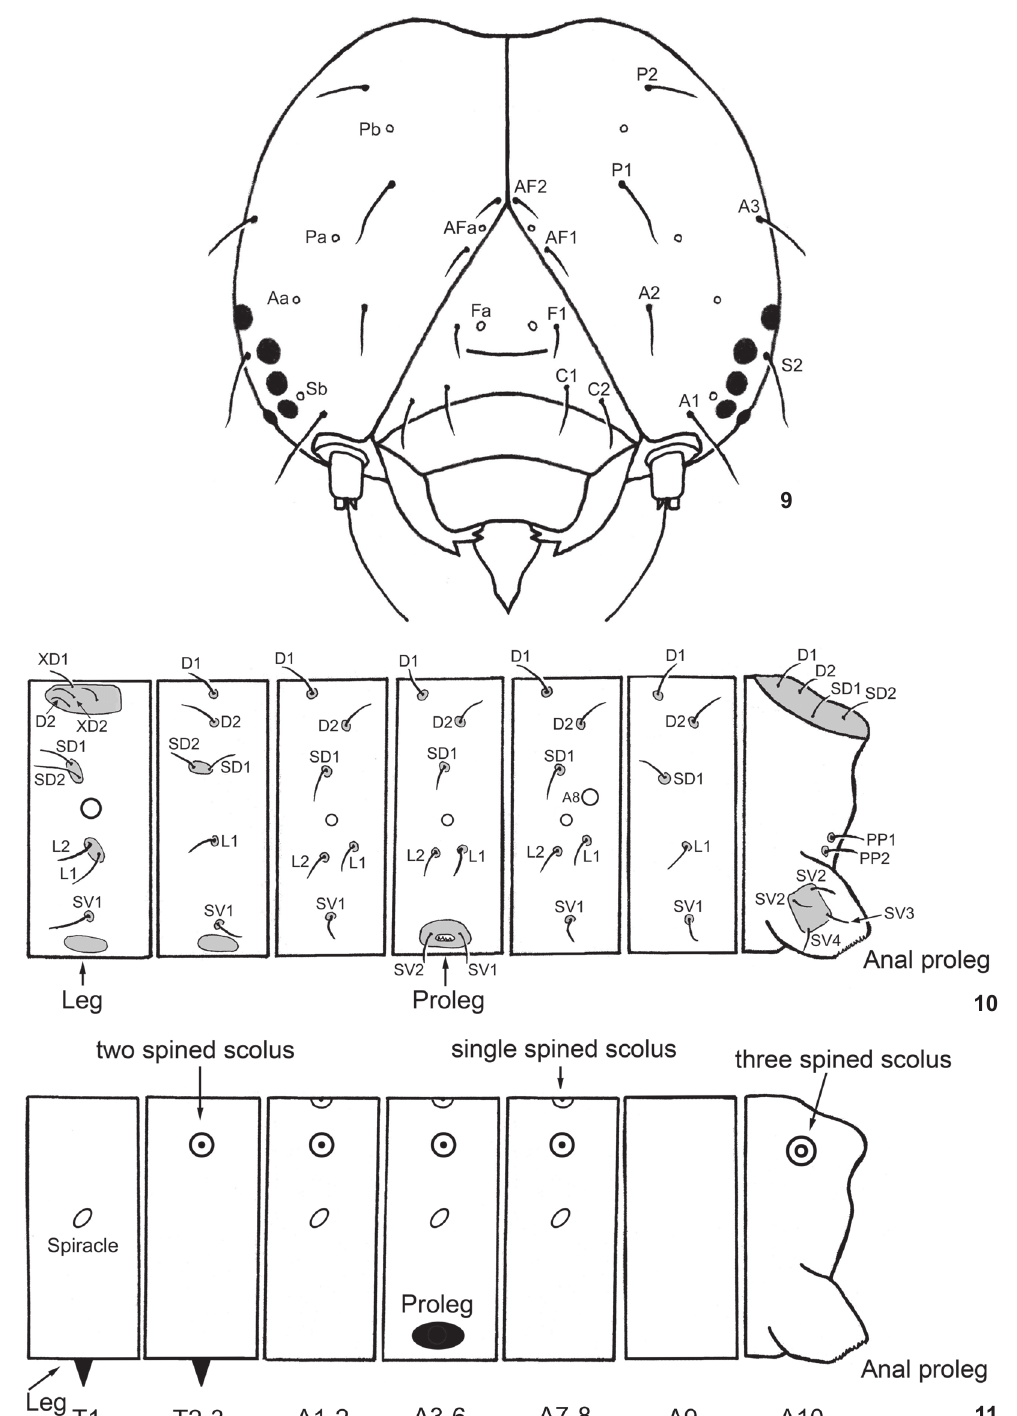
Figures 9-11. Diaethria clymena janeira : (9) head chaetotaxy of first instar; (10-11) larval body diagrams: (10) first instar chaetotaxy; (11) fifth instar scoli distribution